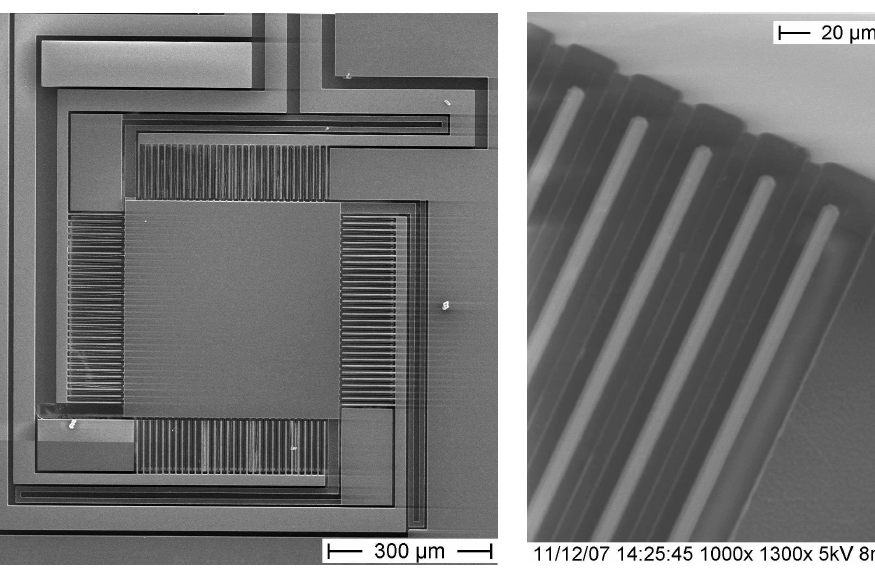
Figure 6: SEM images of fabricated comb-drive actuated micromirrors. Left: overview of a fabricated micromirror. Right: Close-up combs and suspensions. The lower suspensions and combs on the mirror appear in dark (low height), while the elevated regions of the mirror surface and fixed combs appear bright (high